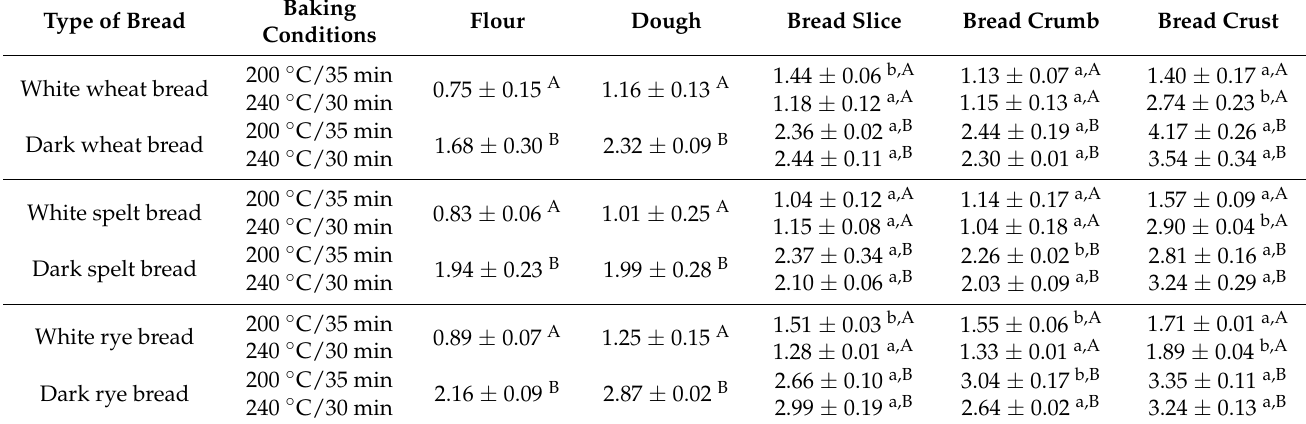
Table 1. The reducing capacity of hydrophilic fraction (H-RC) from flours, doughs, slices, crumbs, and crusts originated from white and dark wheat, spelt and rye breads baked at 200 ◦ C for 35 min or at 240 ◦ C for 30 min ( µ mol Trolox/g